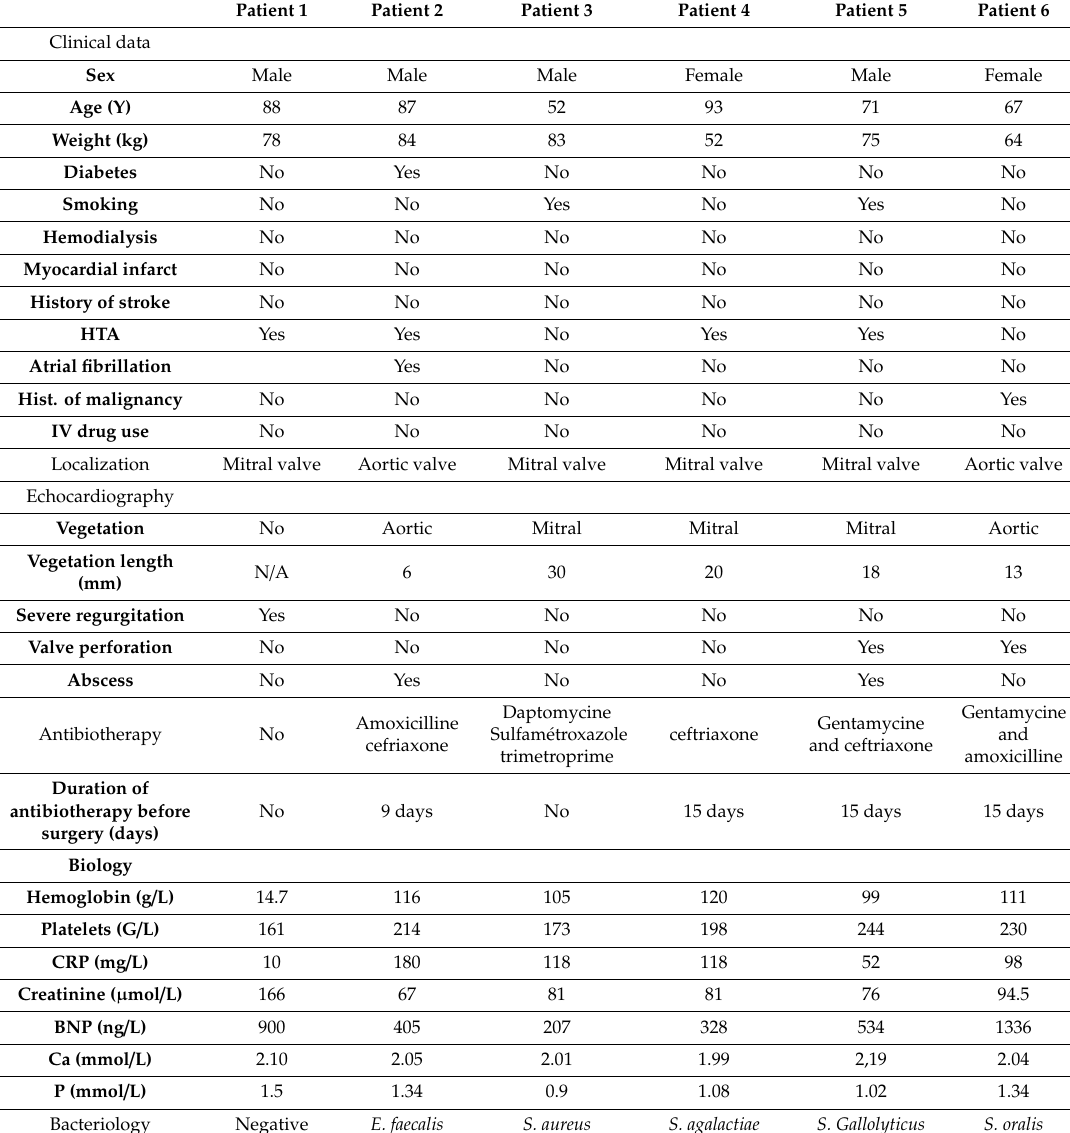
Table 1. Demographic and clinical data at